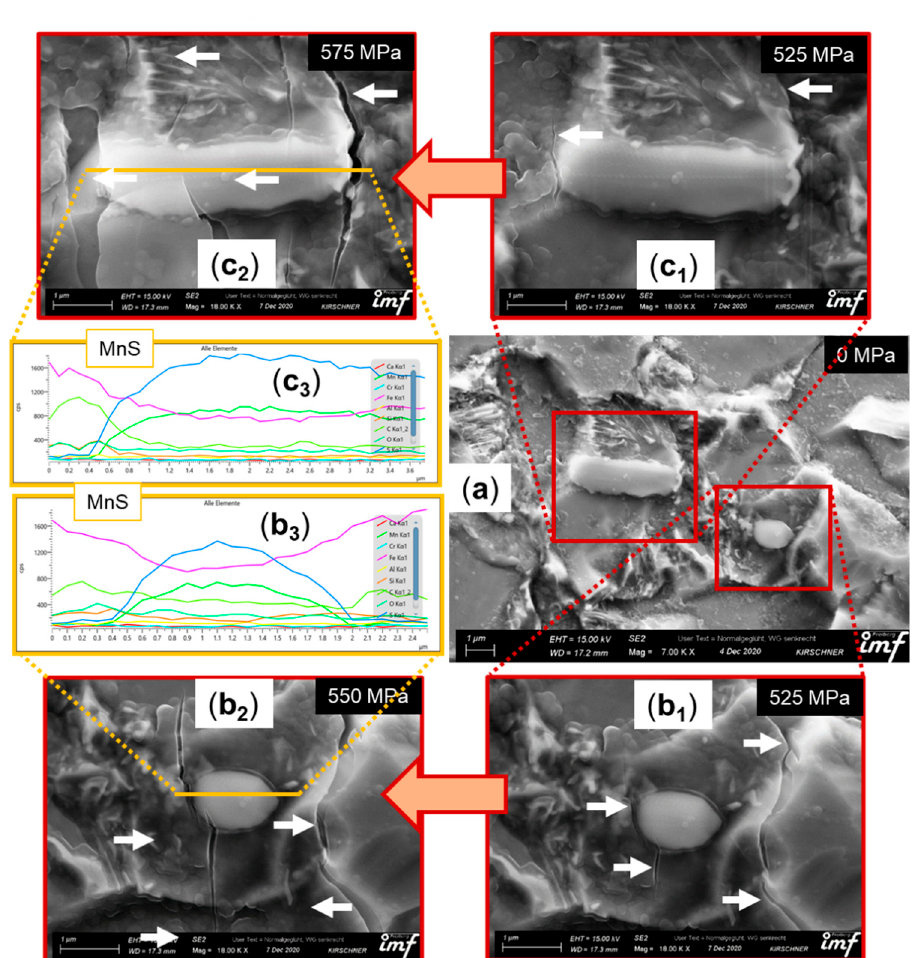
Figure 13. ( a ) Localized single inclusion identification, ( b ) represents a round inclusion at 525 MPa and 550 MPa, respectively. ( c ) represents an elliptical inclusion at 525 MPa and 550 MPa, respectively. EDS show the maximum concentration of manganese and sulfur along the measured length verifying both to be an MnS inclusions. The white arrows point to the local damage initiation and growth.